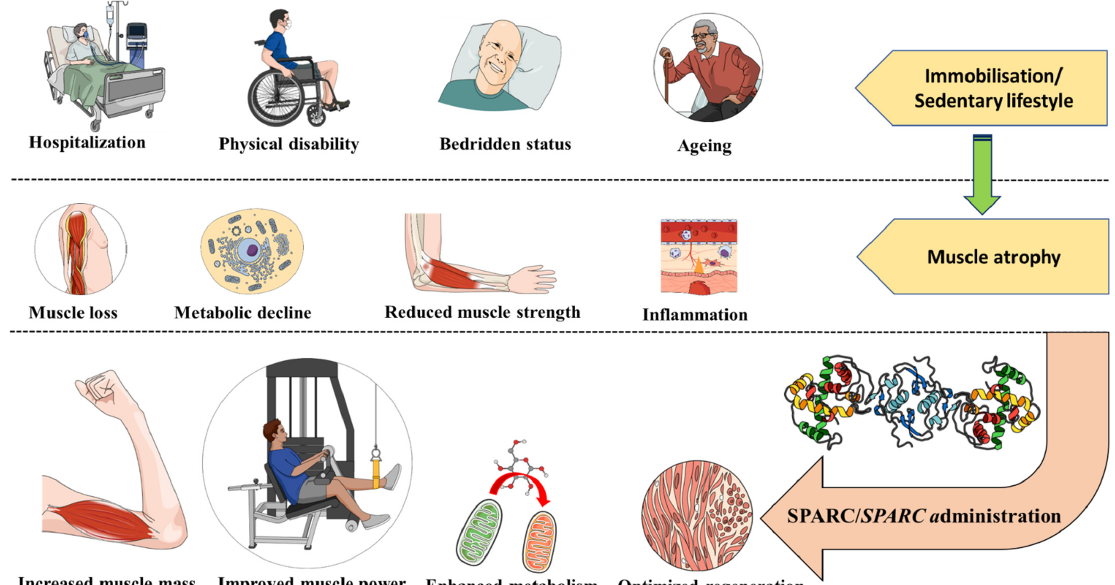
Figure 1. Secreted Protein Acidic and Rich in Cysteine (SPARC/ SPARC ) as a muscle atrophy therapy. Situations such as hospitalization, physical disability or being bedridden represent an immobilization that might lead to muscle atrophy. Ageing (usually accompanied with a sedentary lifestyle) is another risk factor for the muscle atrophy. SPARC properties of enhancing muscles mass, strength and metabolism are towards counteracting muscle atrophy and highlight SPARC/ SPARC (protein administration or gene therapy) as a molecular therapy for muscle